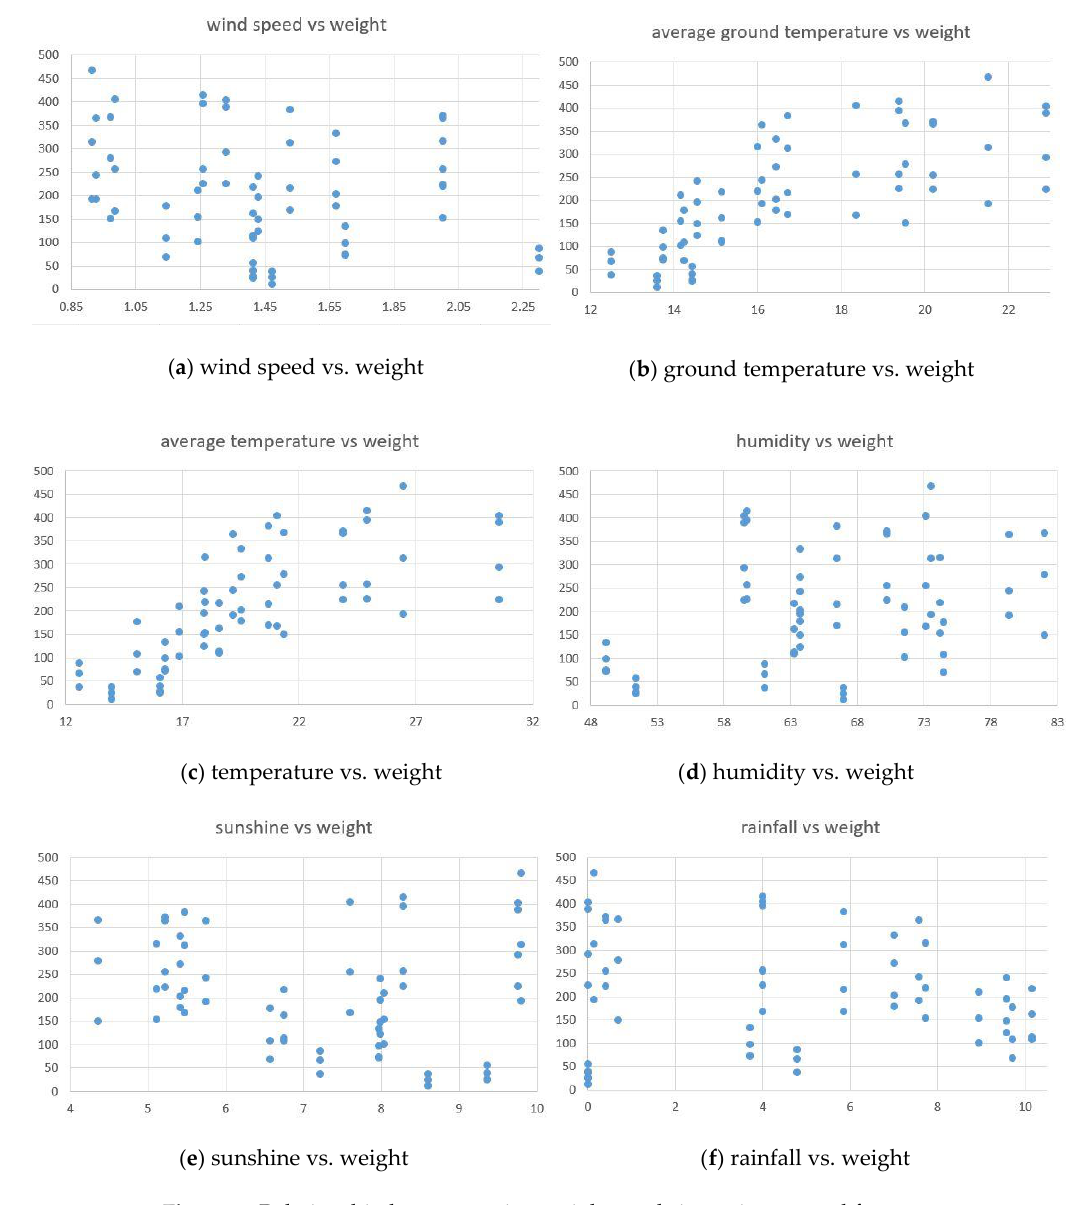
Figure 3. Relationship between onion weights and six environmental factors.